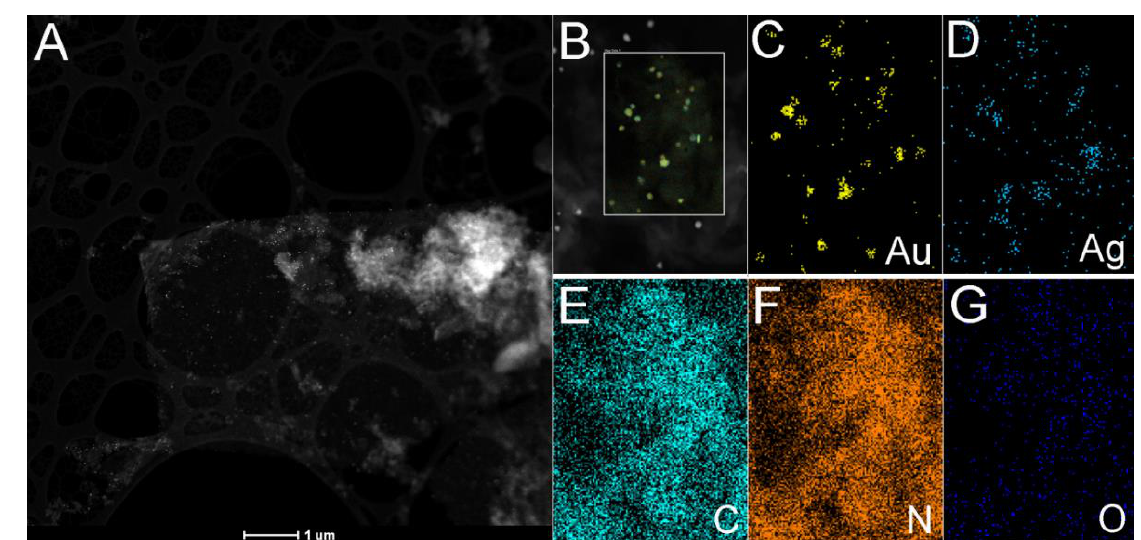
Figure 2. HAADF-STEM image of AuAg-g-C 3 N 4 nanohybrid 3 ( A ) displaying a 2D sheet of g-C 3 N 4 with metal nanoparticles grafted at the surface. EDS elemental mapping images for elements Au, Ag, C, N and O: image ( B ) displays all elements mapping at a time, while images ( C – G ) display the individual elemental maps.